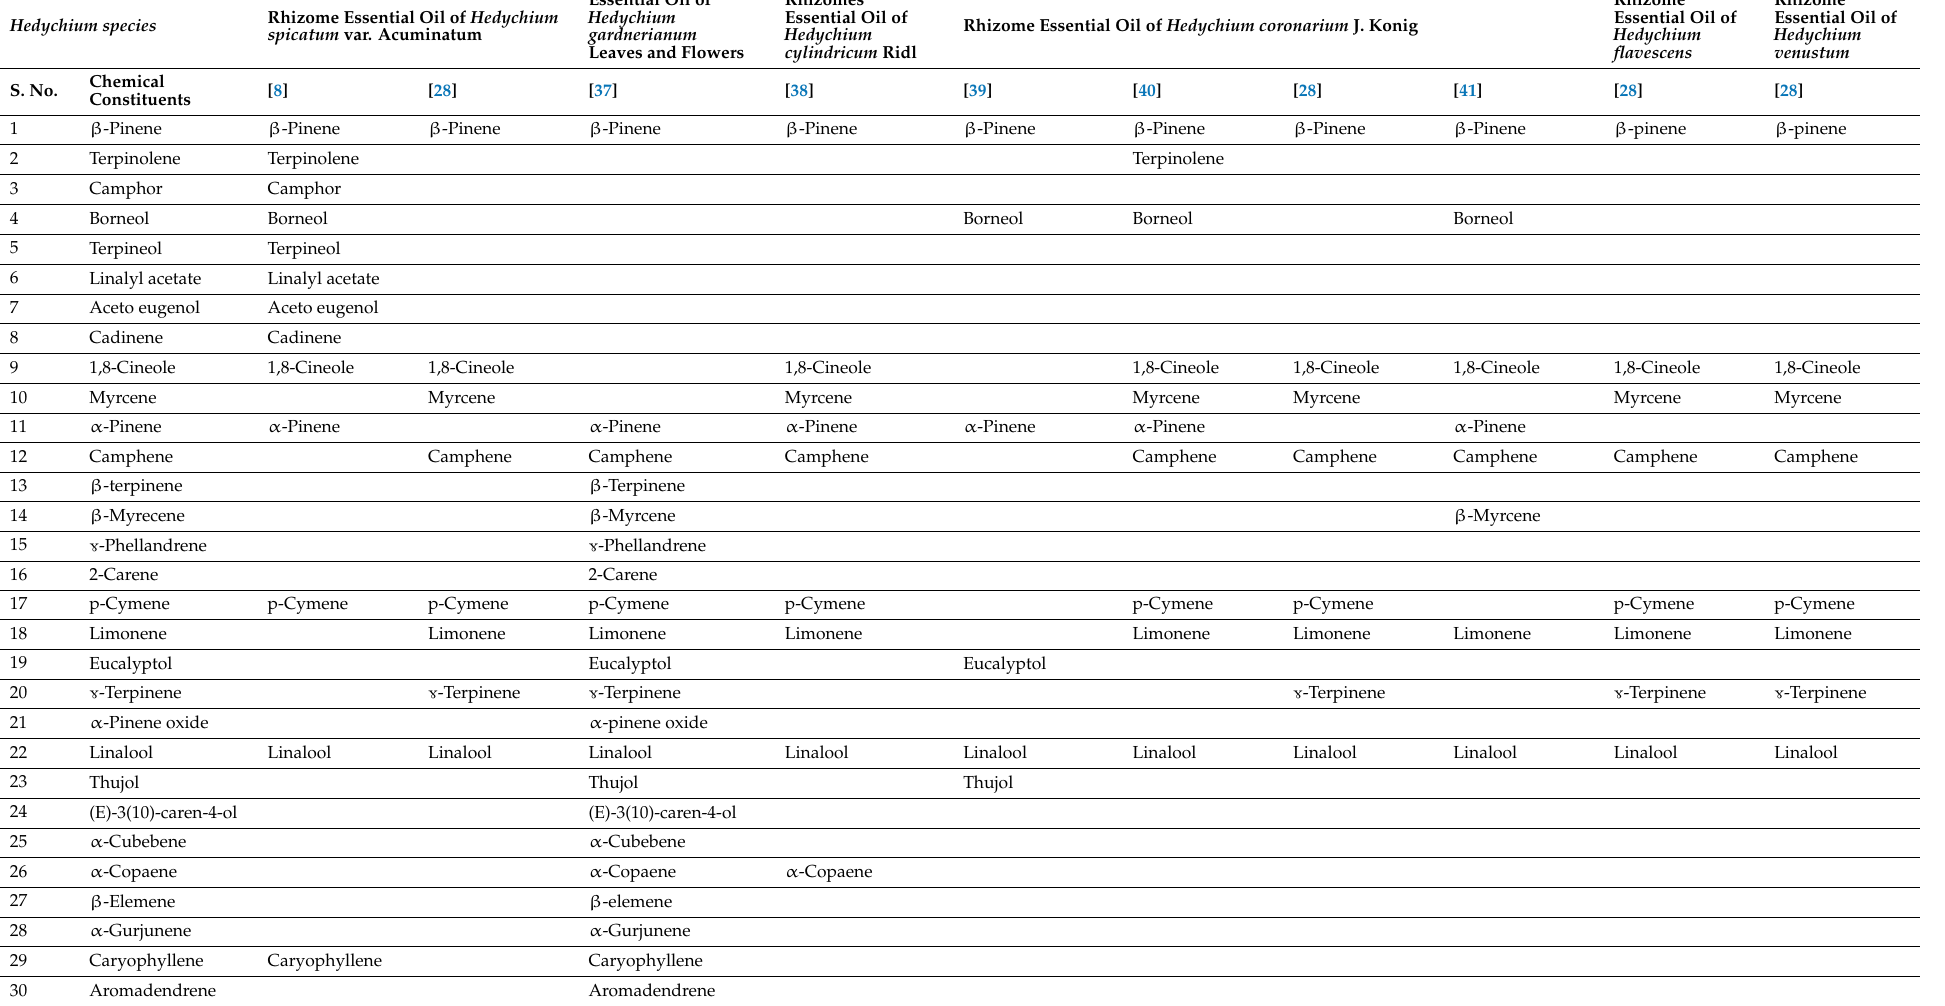
Table 3. Chemical constituents present in essential oil of rhizomes/leaves of Hedychium species